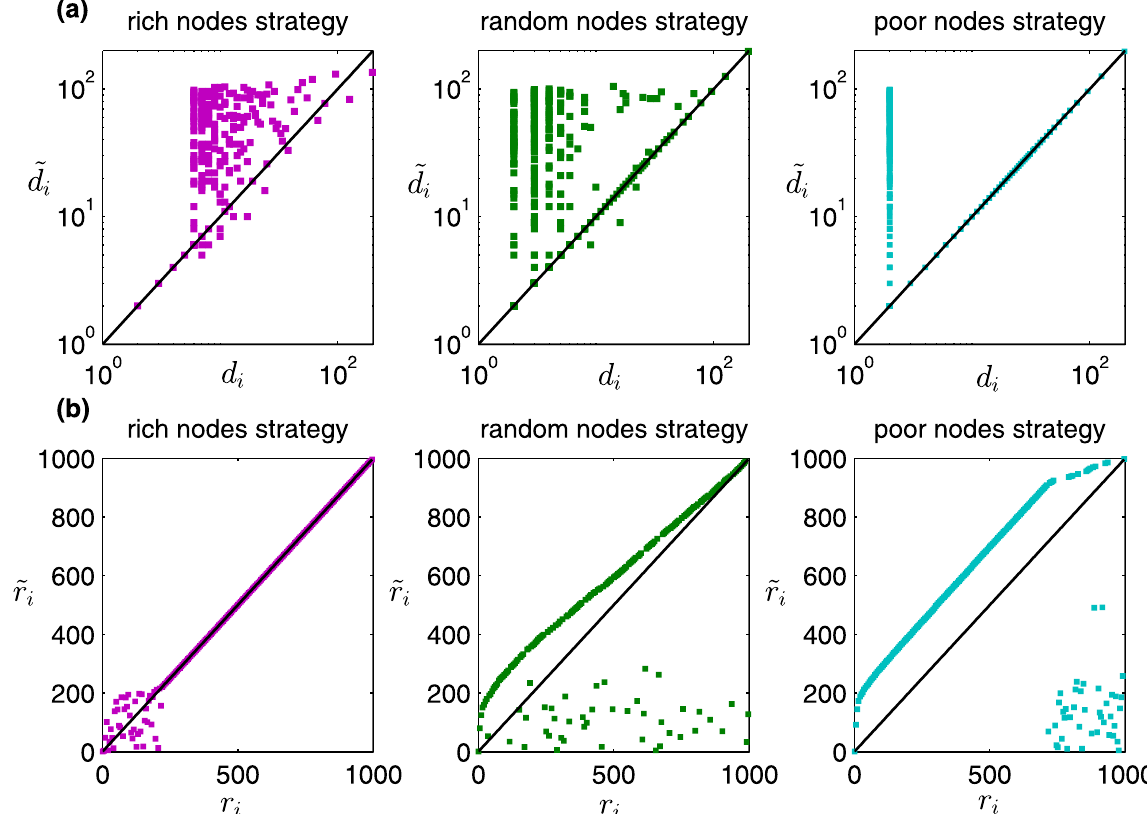
Figure 6. Degree pairs ( a ) and rank pairs ( b ) of nodes before and after information disturbance under three typical disturbance strategies. The original network is the same as the one we used in Fig. 2. The cost constraint parameter θ is 0.1 and the disturbance range parameter ω is 20%. The solid lines are the reference lines which represent